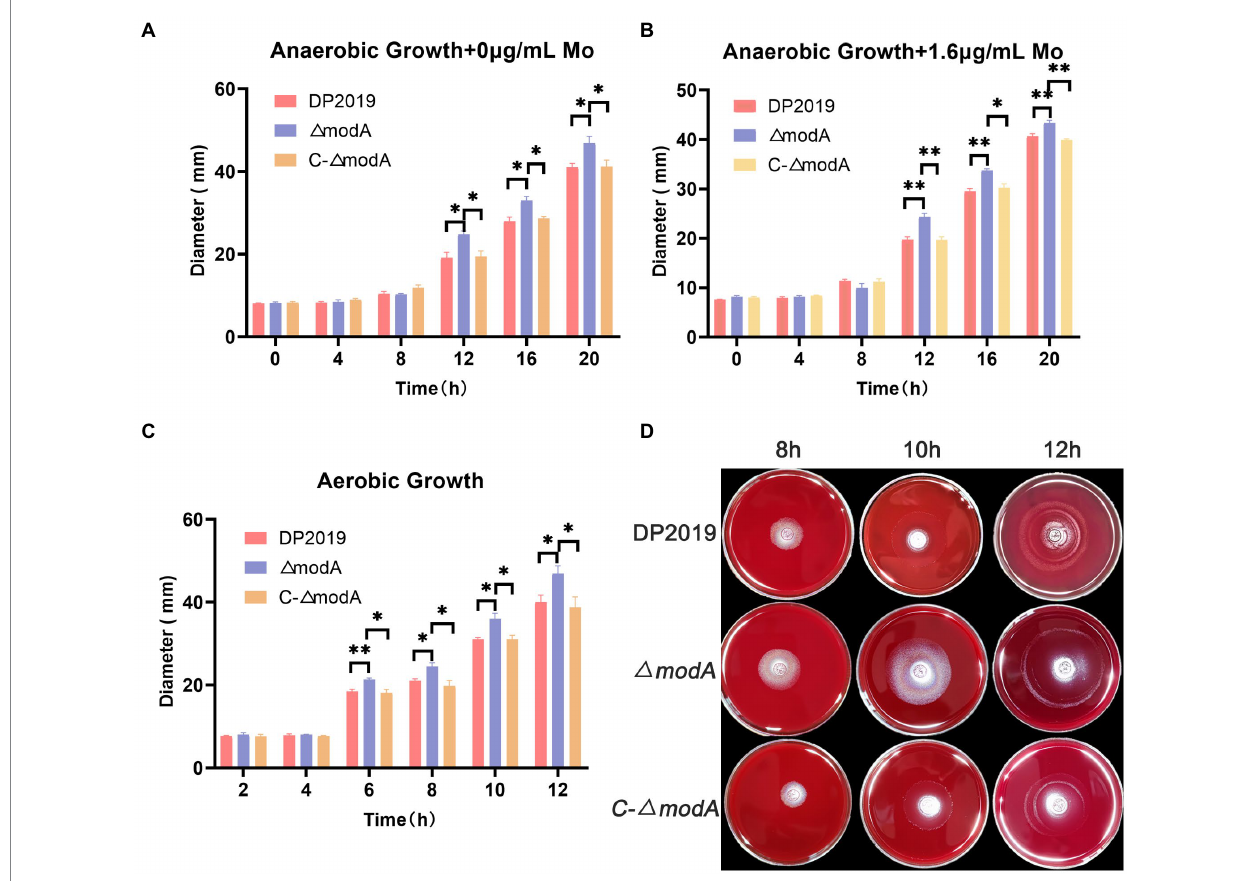
FIGURE 2 Examination of swarming motility. (A) Line graph showing swarming migration distances under anaerobic growth conditions. (B) Line graph showing swarming migration distances under anaerobic growth conditions with 1.6 μ g/mL molybdate supplement to avoid the interference of anaerobic growth defects on the results. (C) Line graph showing swarming migration distances under aerobic growth conditions. (D) Halo images of bacteria swarming on blood agar plates under aerobic growth conditions. Data are presented as the mean ± S.D. of three independent experiments, * p < 0.5, ** p <